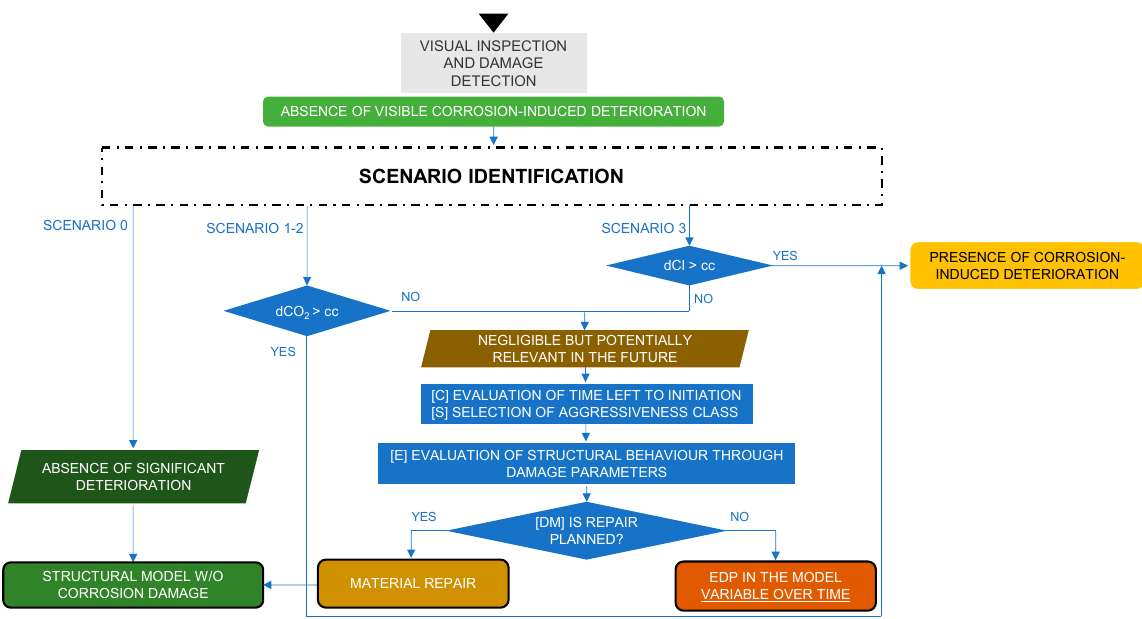
Figure 7. Flow chart to be followed in the case of ‘absence of visible corrosion-induced deterioration’: starting point and possible outcomes. Type of operations required: (C)—calculations, (S)—surveys, (E1)—qualitative evaluations, (DM)—decision making processes.